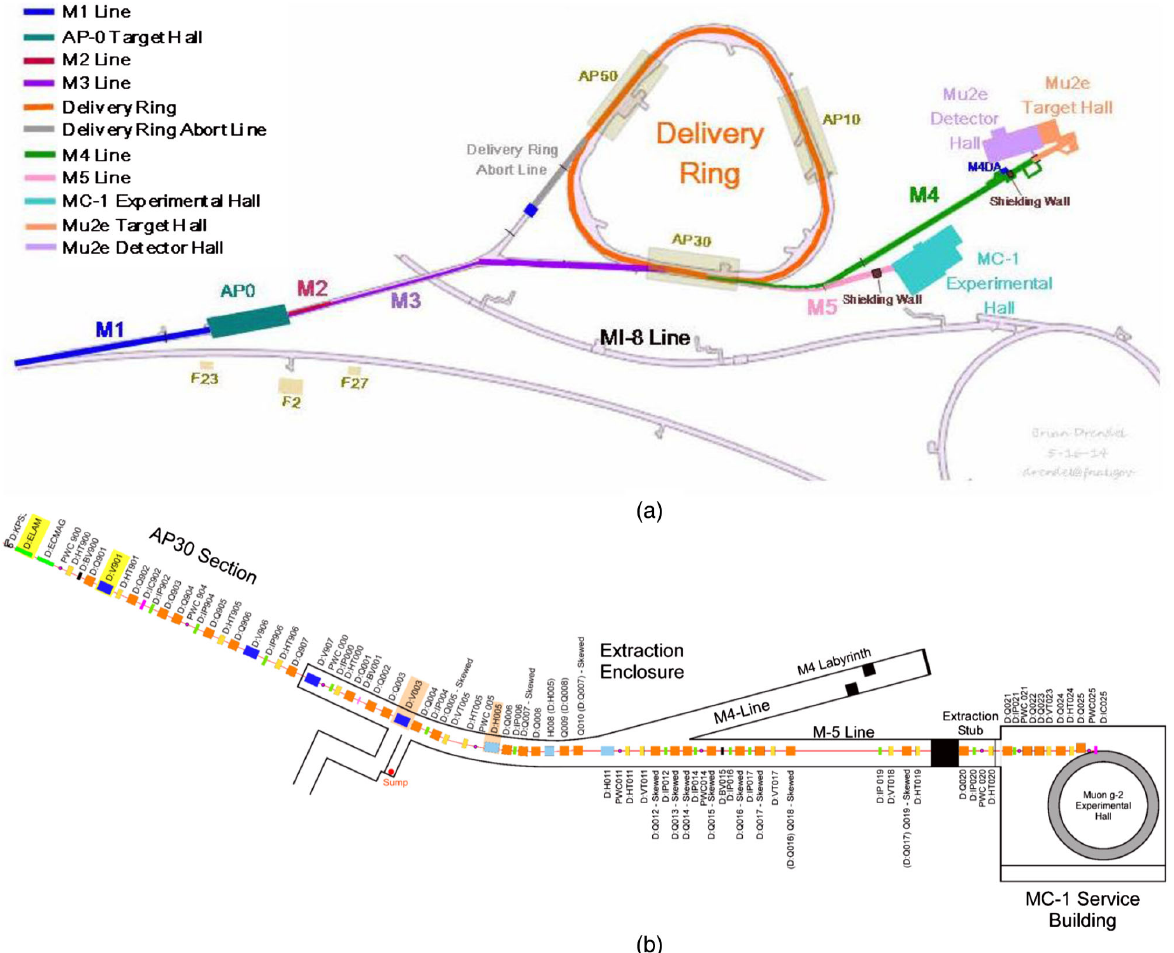
FIG. 2. (a) Schematic representation of the Muon Campus accelerator complex that is used by the Muon g-2 Experiment. Secondaries are produced on a target that then travel through the M2 and M3 lines, which are designed to capture as many 3 . 1 GeV = c muons from pion decays as possible. The beam is injected into the DR wherein a kicker is used to remove the protons, the resulting muon beam is then extracted into the M4 line, and the muon beam is eventually transferred to the M5 line that leads to the muon storage ring (enclosed in the MC1 hall). The combined M2 and M3 line and M4 and M5 line lengths are 280 and 128 m, respectively, along with the DR that has a circumference of 505 m. (b) Schematic layout of the M4-M5 lines. Note that ECMAG is a bending magnet and its upstream edge signals the start of the M4 line ( S ¼ 0 m). AP designates